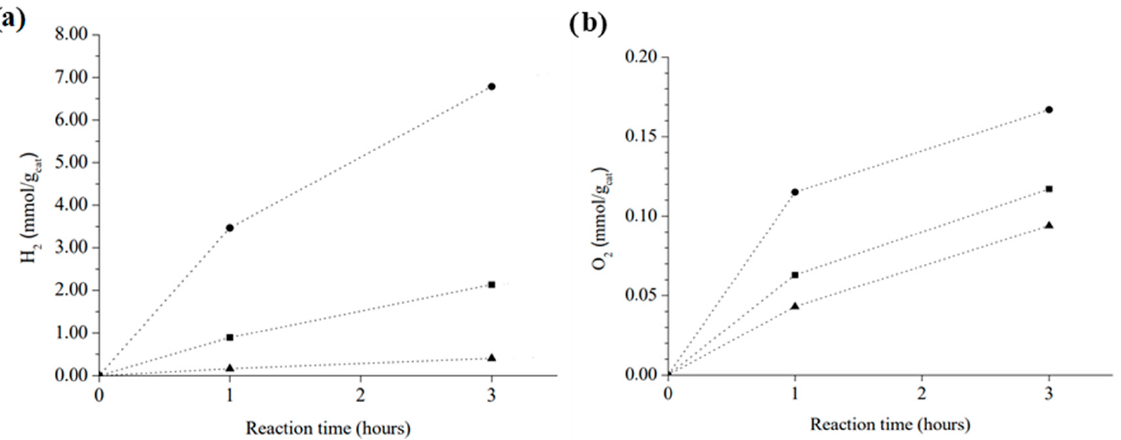
Figure 7. Photocatalytic hydrogen generation of COP–3 in the presence of sacrificial agents. ( a ) Amounts of methanol added: nothing ( (cid:78) ), 2.4 mmol ( (cid:4) ) or 24 mmol ( • ). ( b ) Amounts of (NH 4 )Ce(NO 3 ) 6 added: nothing ( (cid:78) ), 1 mmol ( (cid:4) ) or 3 mmol ( • ).